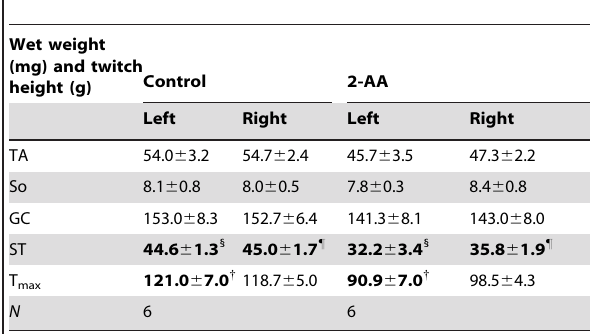
Table 7. Absolute wet-weights of tibialis (TA), soleus (So) and gastrocnemius (GC) muscles, and absolute twitch tensions (ST; single twitch, T max ; maximum response of tetanic stimulation at 50 Hz for 5 sec) of tibialis muscle, at 4 days post 2-AA treatment, versus corresponding control muscle.